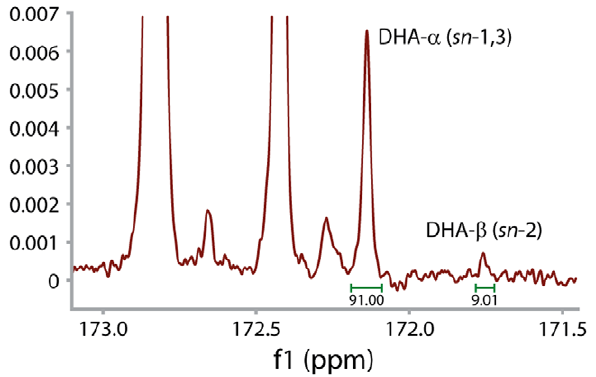
Figure 5. NMR trace showing the positional distribution of DHA on the A.thaliana TAG with the sn -1 and sn -3 positions indicated by DHA- a and sn -2 by DHA- b . DHA is preferentially positioned at sn